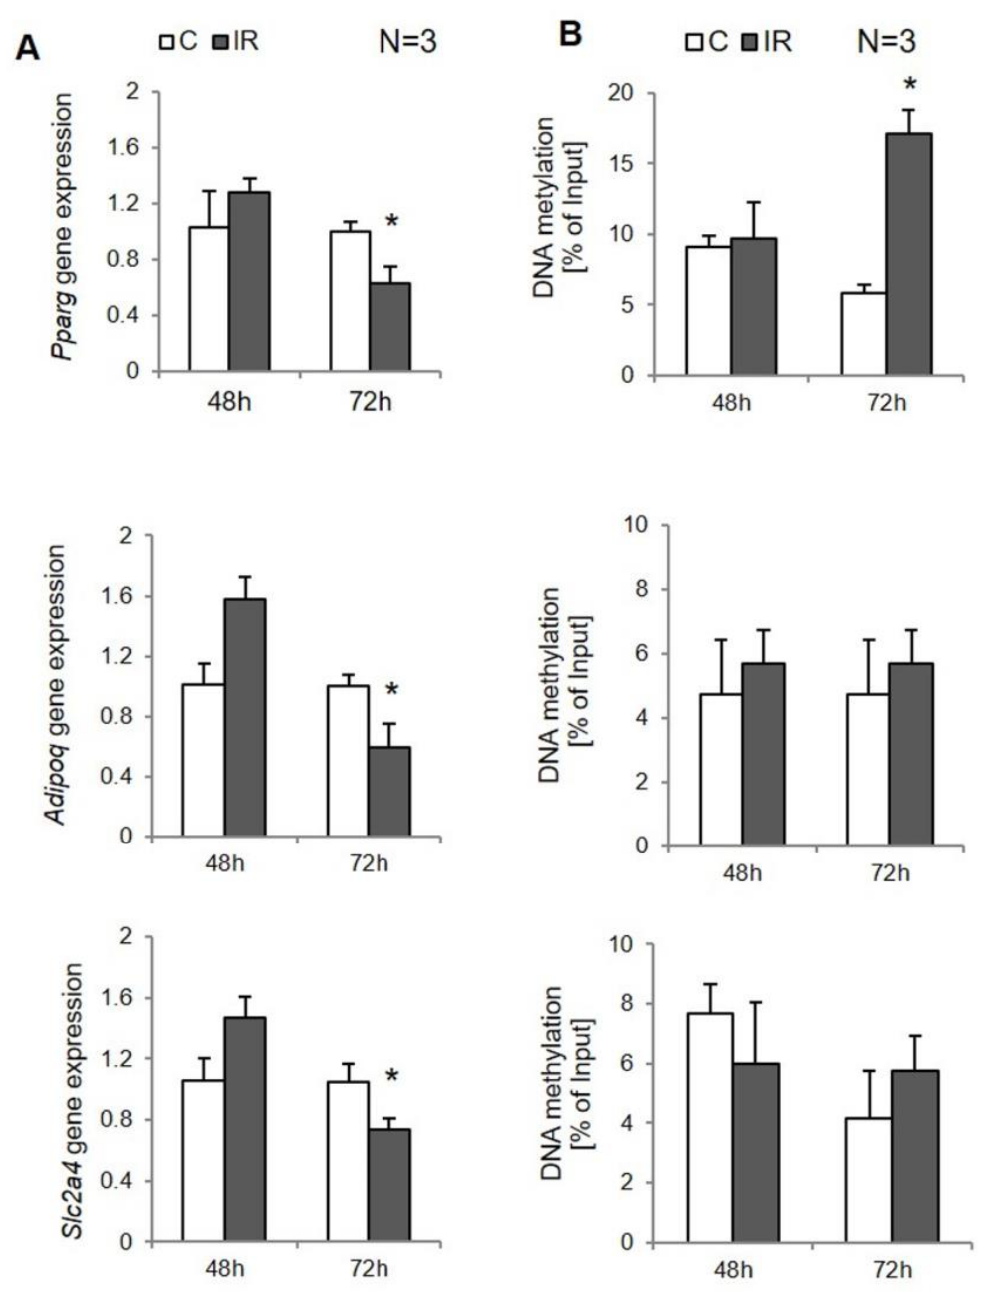
Figure 3. The insulin-sensitizing genes’ expression and their site-specific DNA methylation in 3T3-L1 adipocytes. Controls (C) and induced insulin resistance (IR): ( A ) gene expression (normalized to β -actin gene), ( B ) site-specific DNA methylation (% of input), * p < 0.05. DNA methylation at the protomer sites of the analyzed genes did not differ between experimental cells, except the Pparg gene, where the methylation rate was twice as high in IR cells compared to controls after 72 h of IR induction ( p < 0.000; Figure 3B). At the same time, in experimental adipocytes 72 h after induction of insulin resistance, a negative correlation was observed between methylation of the PRRAG promoter and its expression (R = − 0.78, p = 0.038). No other correlations were